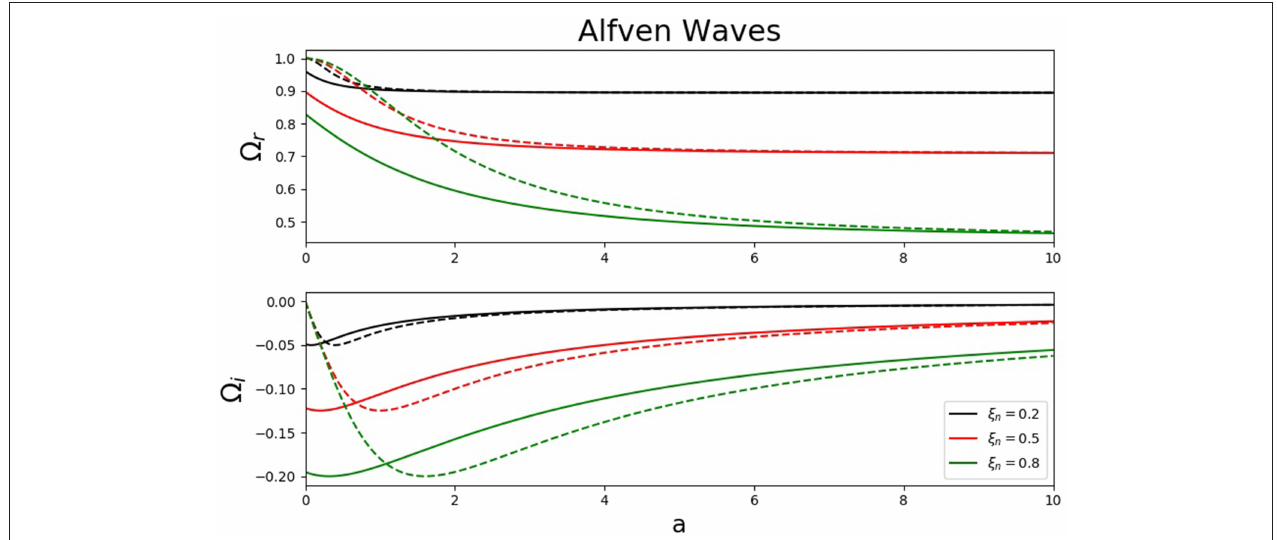
FIGURE 2 | The variation of the recombination rate ( R , shown in red line) and the ionization rate ( I , blue line) with height (on logarithmic scale) in the lower solar atmosphere based on a VALIII C solar atmosphere model ( Vernazza et al., 1981).